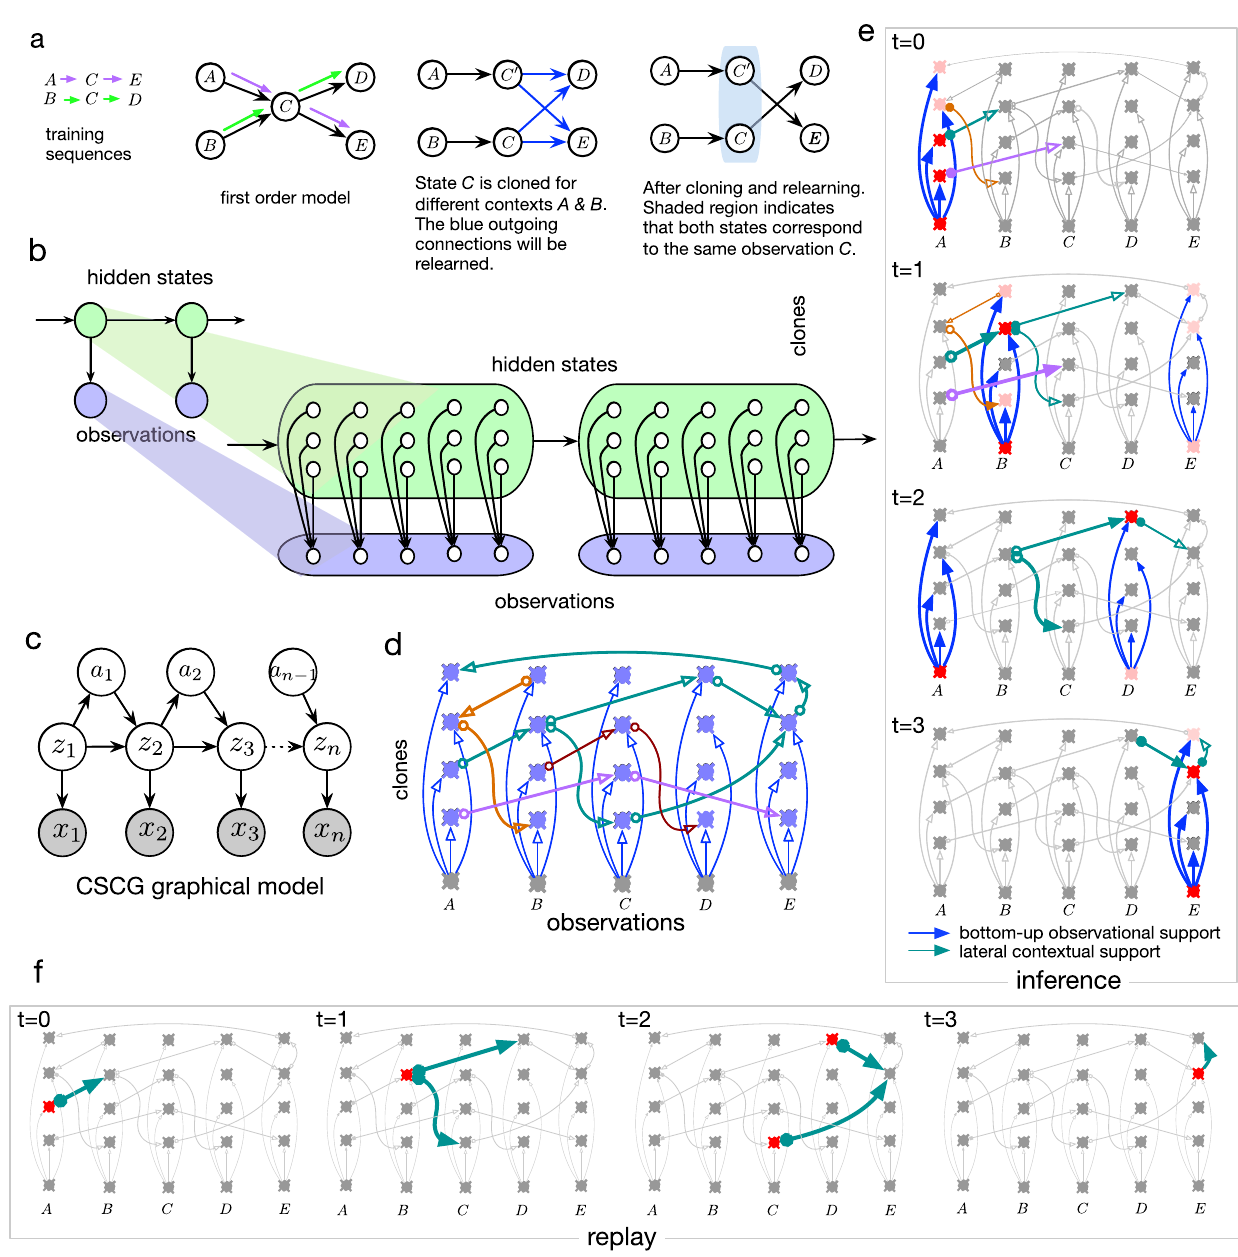
Fig. 1 Clone-structured cognitive graph. a Sketch explaining dynamic Markov coding. A fi rst-order Markov chain shown as a graph between nodes representing its states, modeling observation sequences A → C → E (purple arrows) and B → C → D (green arrows) will also assign high probability to the sequence A → C → D because higher-order information is lost at state C . (Middle) Higher-order information can be recovered by cloning the state C for different contexts, and then relearning their outgoing connections (blue) to result in the graph on the right. b Cloning structure of dynamic Markov coding can be represented in an HMM with a structured emission matrix, the cloned HMM. c Probabilistic graphical model for CSCG which extends cloned HMMs in b by including actions. d Neural implementation of cloned HMM. Arrows are axons, and the lateral connections implement the cloned HMM transition matrix. Different sequences are in different colors, e.g., A → C → E in purple. Neurons in a column are clones of each other that receive the bottom-up input (blue arrows) from the same observation. e Inference dynamics in the cloned HMM neural circuit. Neural activations strengths are represented in shades of red. Activations that propagate forward are the ones that have contextual (lateral) and observational (bottom-up) support. f Replay within the circuit for the sequence A → B → ( C , D ) → E → E